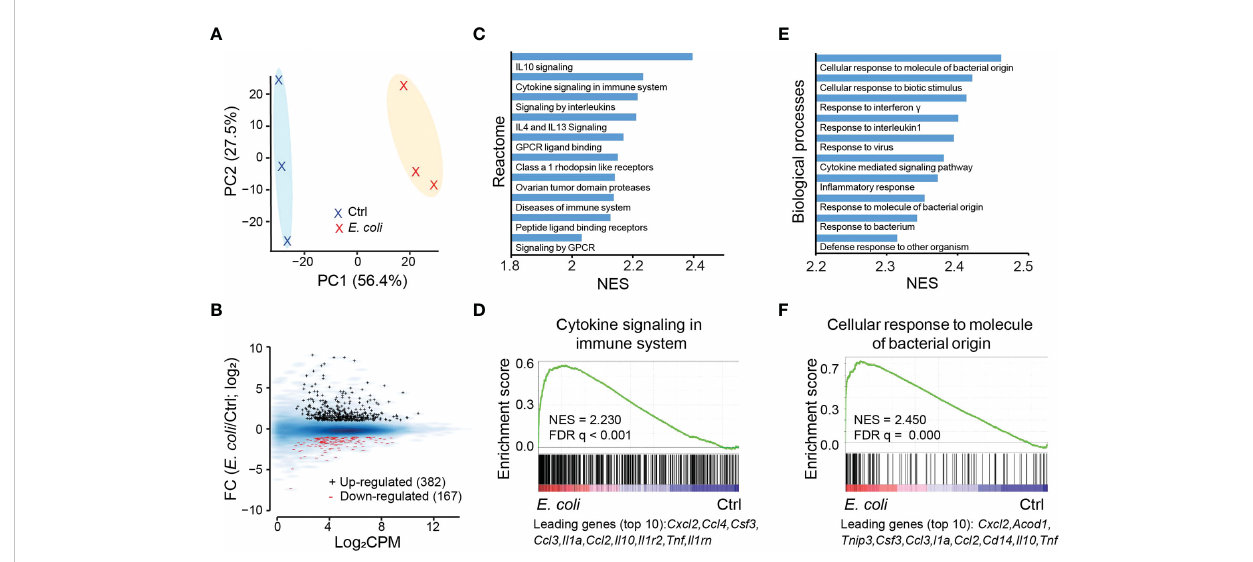
FIGURE 2 Transcriptional response to E. coli infection in the spleen. (A) PCA analysis based on gene expression showing a clear separation of E. coli treated samples from the untreated samples (Ctrl). (B) MA plot for genes differentially expressed between E. coli treated and Ctrl samples. Black +: genes upregulated after E. coli infection; red -: genes downregulated after E. coli infection. Blue smoothed heat map: all expressed genes. (C) Top 10 gene sets for Reactome pathways that are upregulated in the samples treated with E. coli as predicted from GSEA analysis (FDR q < 0.01). NES: normalized enrichment score. (D) GSEA analysis for expressed genes ranked by fold change of expression ( E. coli /Ctrl) against the Reactome gene set “ cytokine signaling in immune system ” , with top 10 up-regulated genes indicated at the bottom. (E) Top 10 gene sets for gene ontology “ biological processes ” that are upregulated in samples treated with E. coli as predicted from GSEA (FDR q < 0.01 for all). (F) GSEA analysis for expressed genes ranked by fold change of expression E. coli /Ctrl) against the biological process “ cellular response to molecule of bacterial origin ” , with top 10 up-regulated genes indicated at the